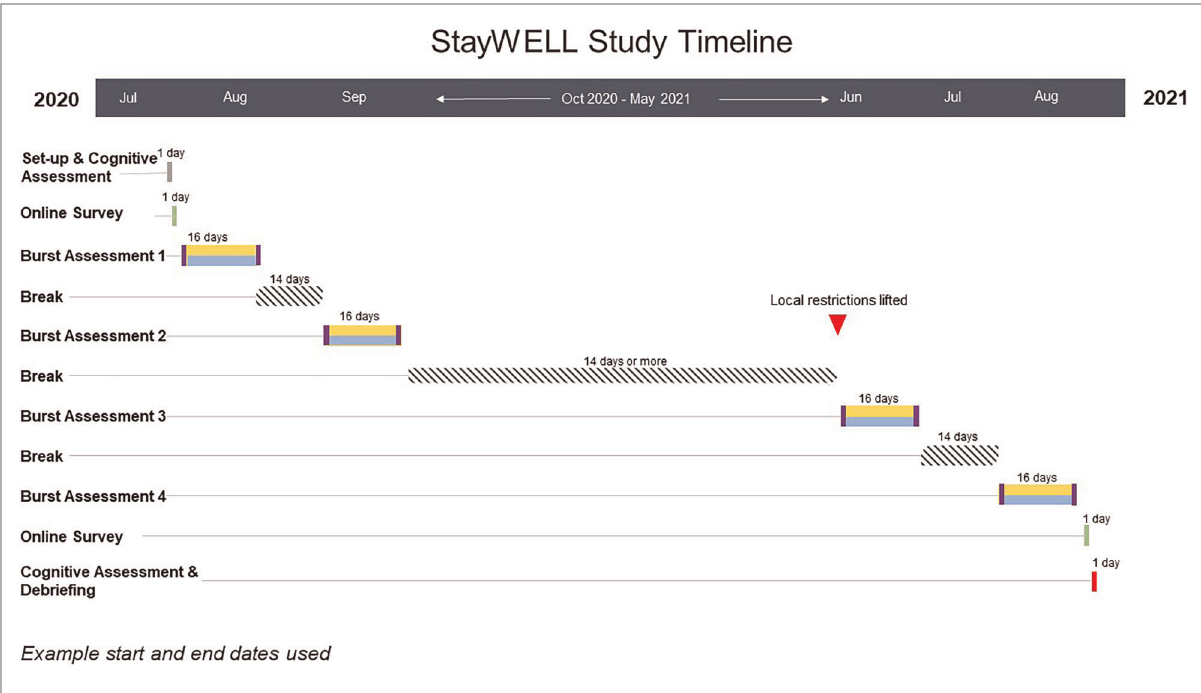
FIGURE 1 Exemplary timeline of StayWELL study